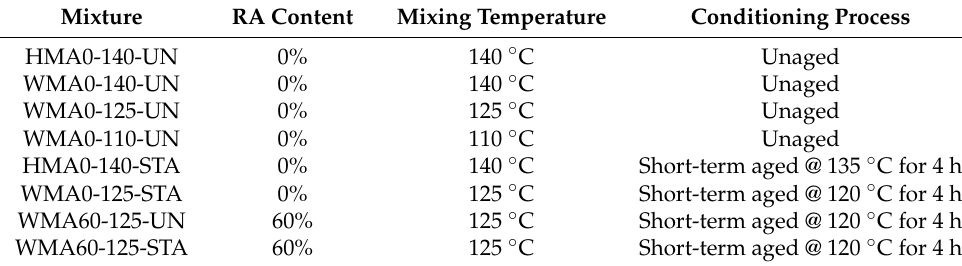
Table 1. Mixture